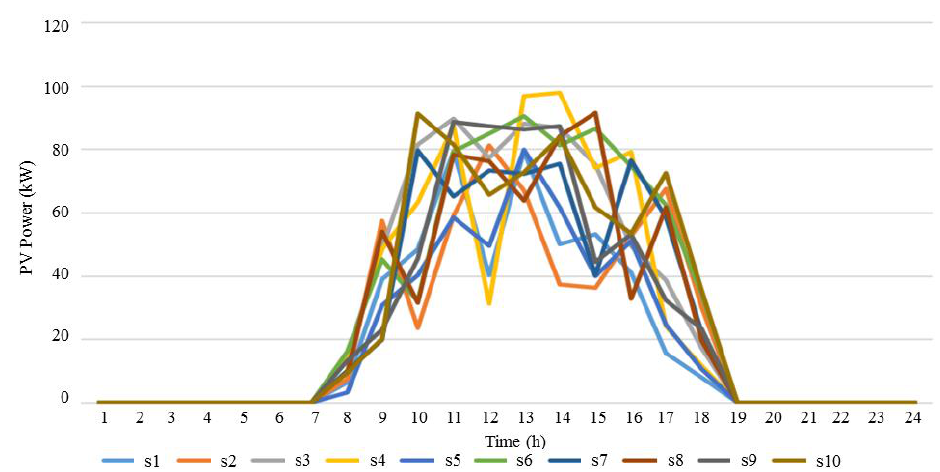
Figure 3. Photovoltaic (PV) power scenarios considered.